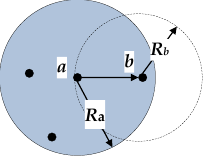
Figure 2. Communication coverage radius of a